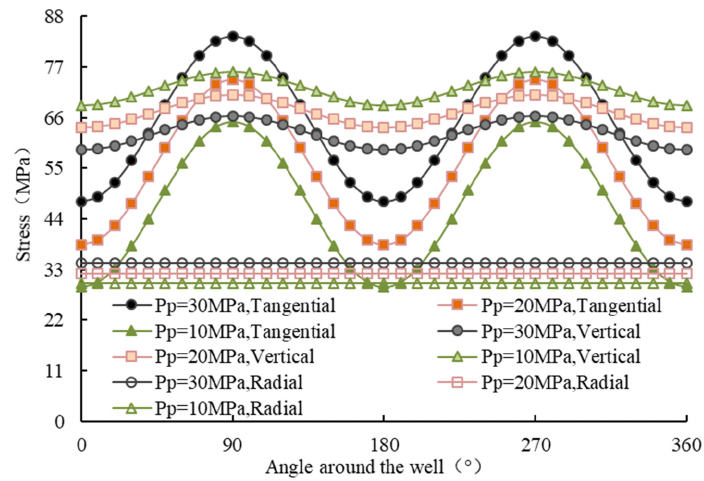
Figure 6. The evolution of total stress around well with pressure decline.